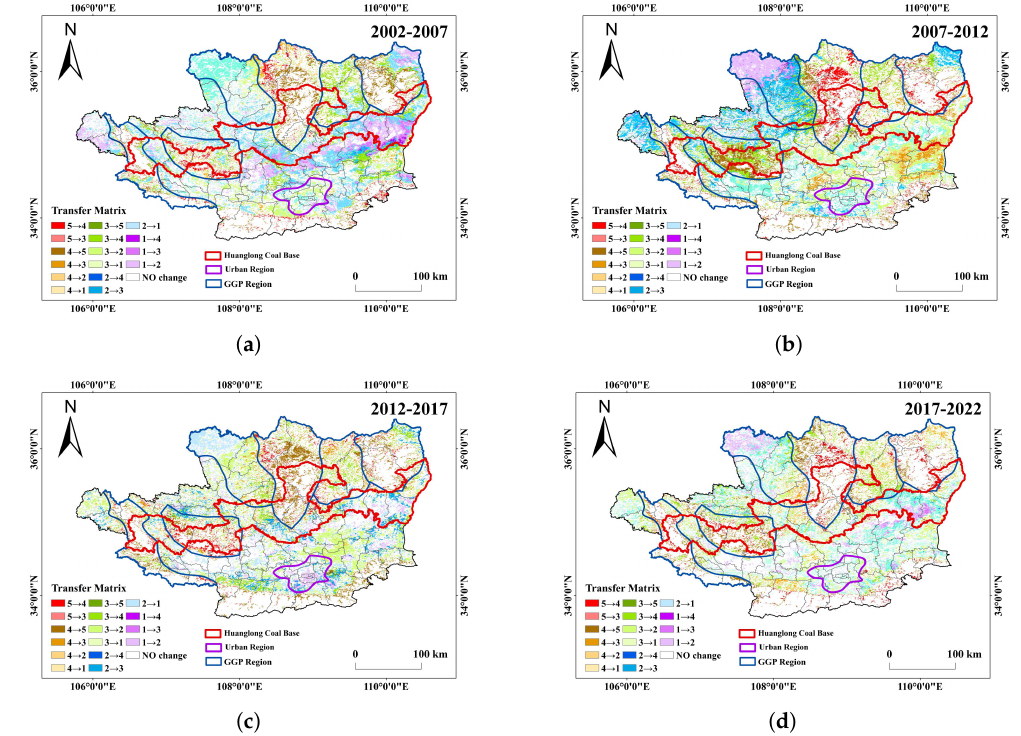
Figure 16. RSEI transfer matrix of ( a ) 2002–2007, ( b ) 2007–2012, ( c ) 2012–2017, and ( d )